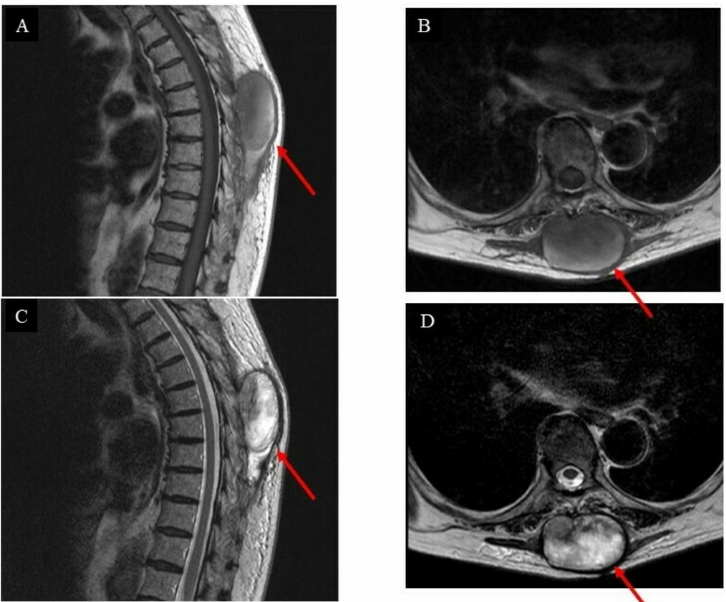
Figure 4. Images of the intrinsic back musculature of the patient three months after wide resection: ( A ) sagittal magnetic resonance imaging (MRI) T1-weighted sequence; ( B ) axial MRI T1-weighted sequence; ( C ) sagittal MRI T2-weighted sequence; ( D ) axial MRI T2-weighted sequence.